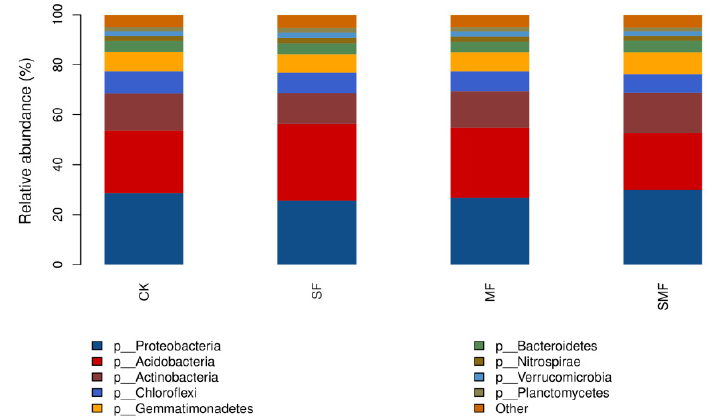
Figure 3. Barplots of soil bacterial community under silicon fertilizer and microbial agent treatment at the phylum at the phylum level.